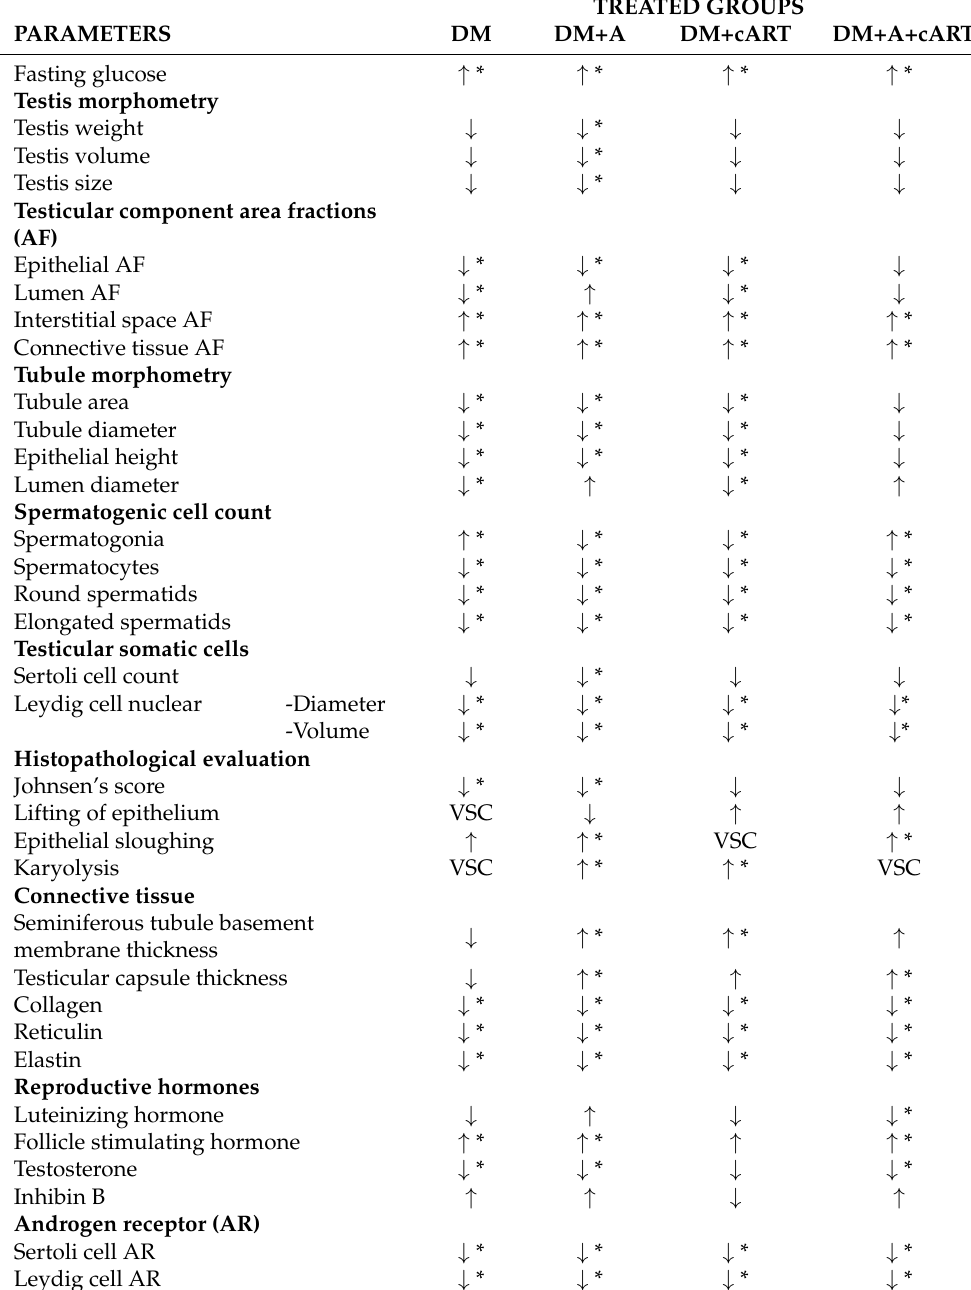
Table 4. Summary of the study’s